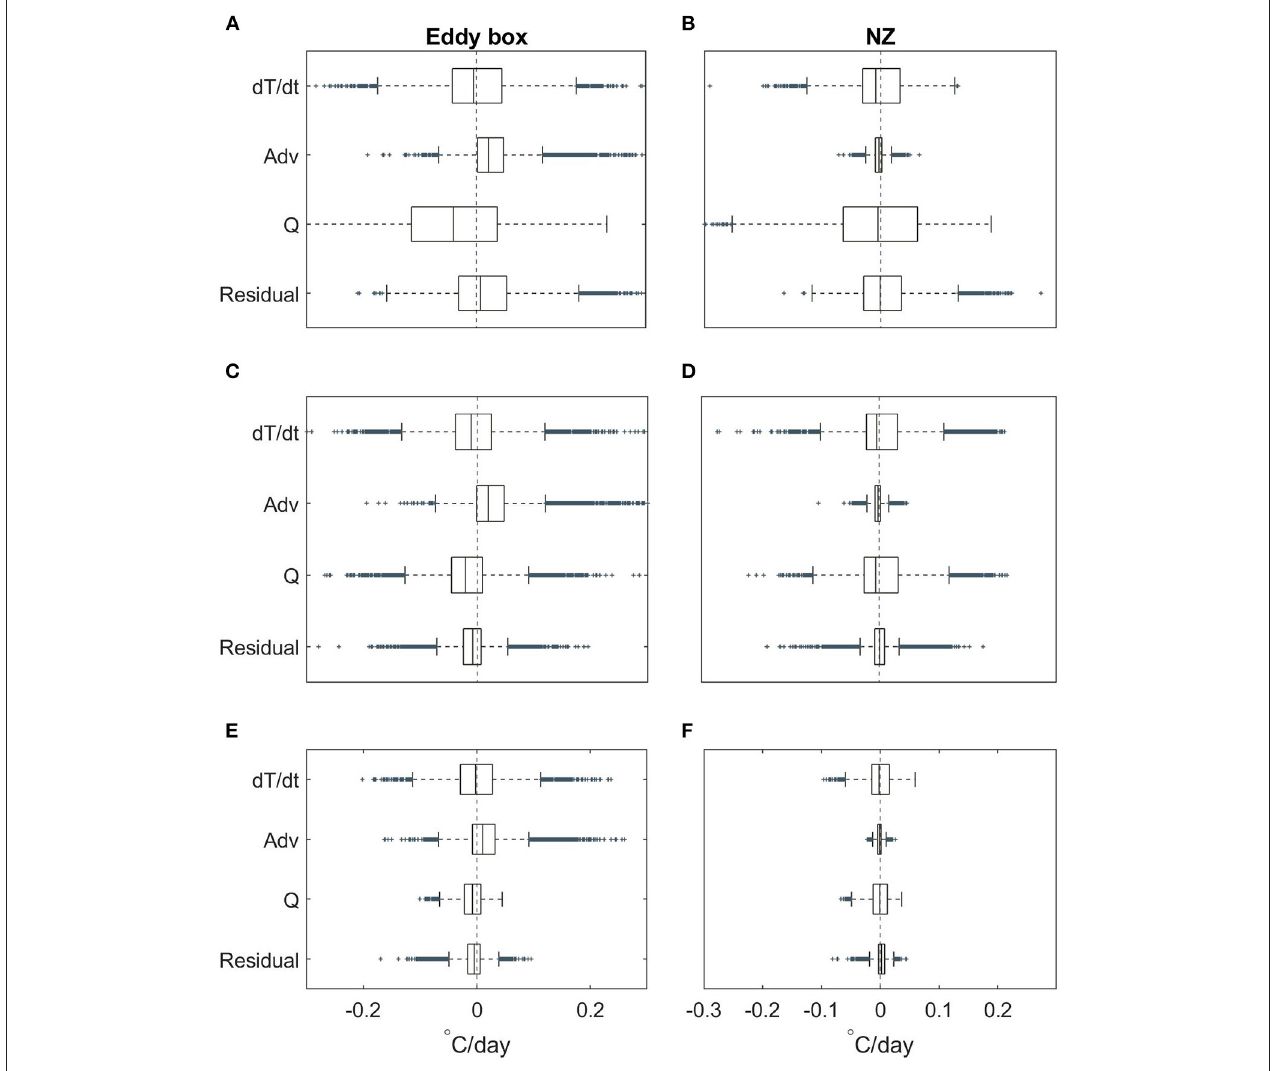
FIGURE 8 | Boxplots showing the statistical distribution of each term in the heat budget calculated across the three formulations: MLD 30 (A,B) , MLD V (C,D) , and MLD 150 (E,F) for the Eddy box (left column) and the NZ box (right column). The boxplots are based on the daily values in each box over the 30-year study period (1985–2014).